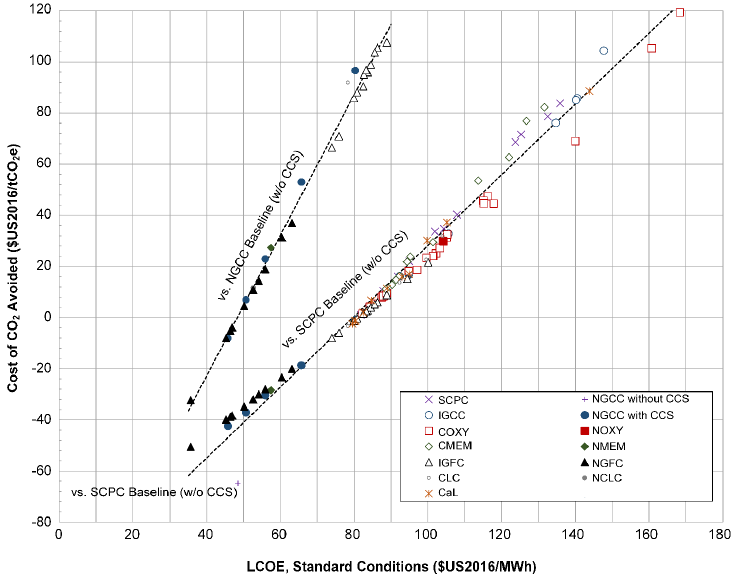
Figure 14. Scatter plot of the calculated LCOE at standard conditions of each plant vs. the calculated life CCA using as ‐ reported prices, when compared against SCPC and NGCC without CO 2 capture. The NGCC baseline plant without CO 2 capture is also included as a point of reference. COXY ‐ 9 has been removed as an outlier. The straight dashed lines are regression lines for each reference group for the points included. Points with CCA above 120 $US2016/tCO 2 e were not included in this plot for clarity. Note that all data plotted above are for CCS ‐ enabled plants, except for a single NGCC without CCS plant.